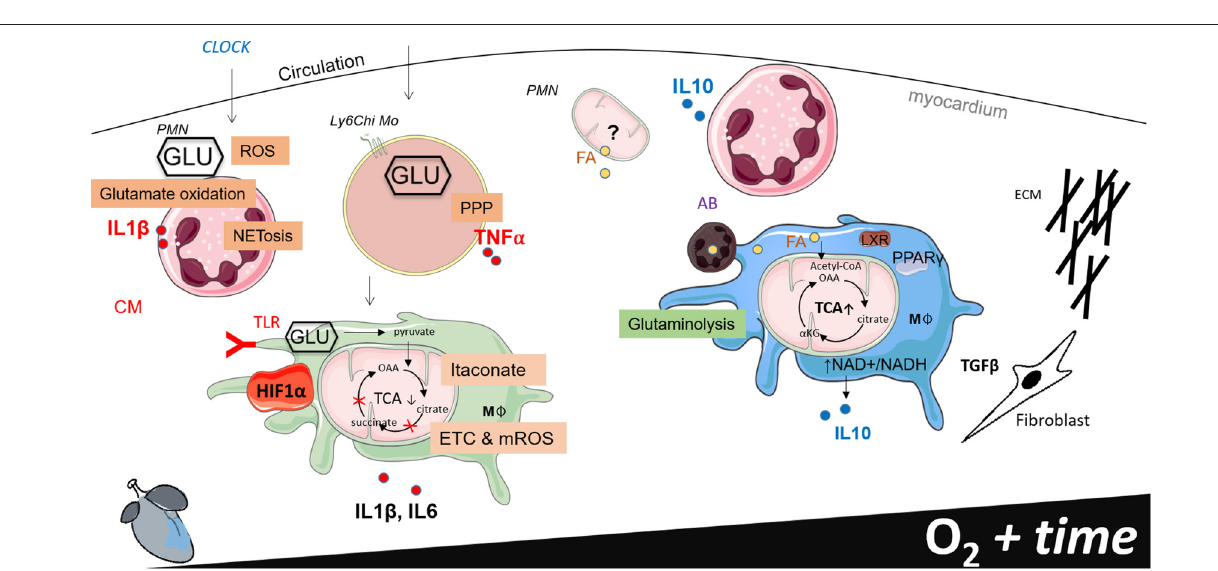
Neutrophil variation also manifests through diurnal